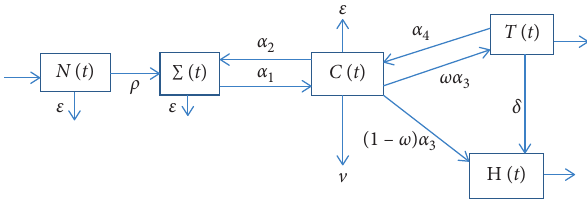
Figure 1: Flow chart of the Khat-chewing